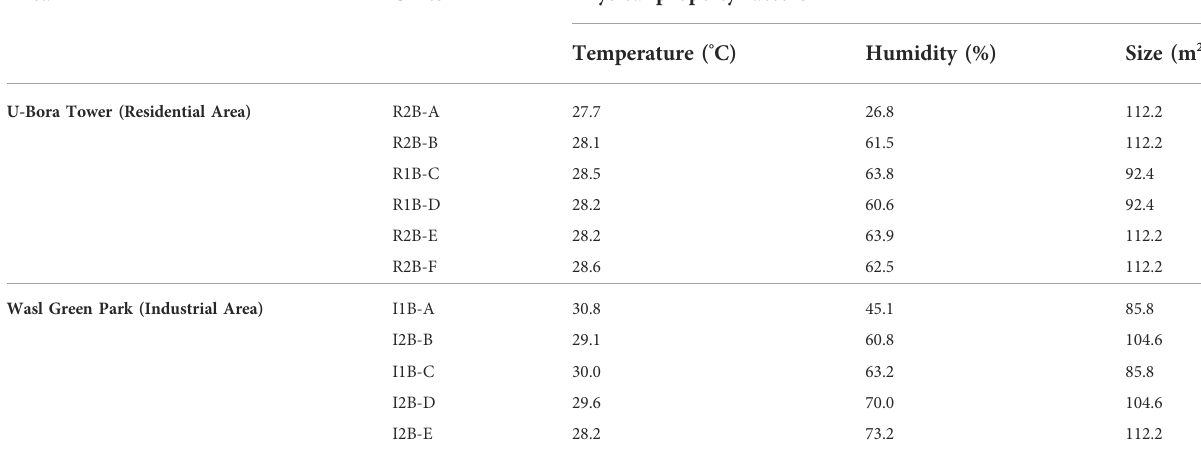
TABLE 5 Distribution of temperature, humidity, and size of the surveyed housing